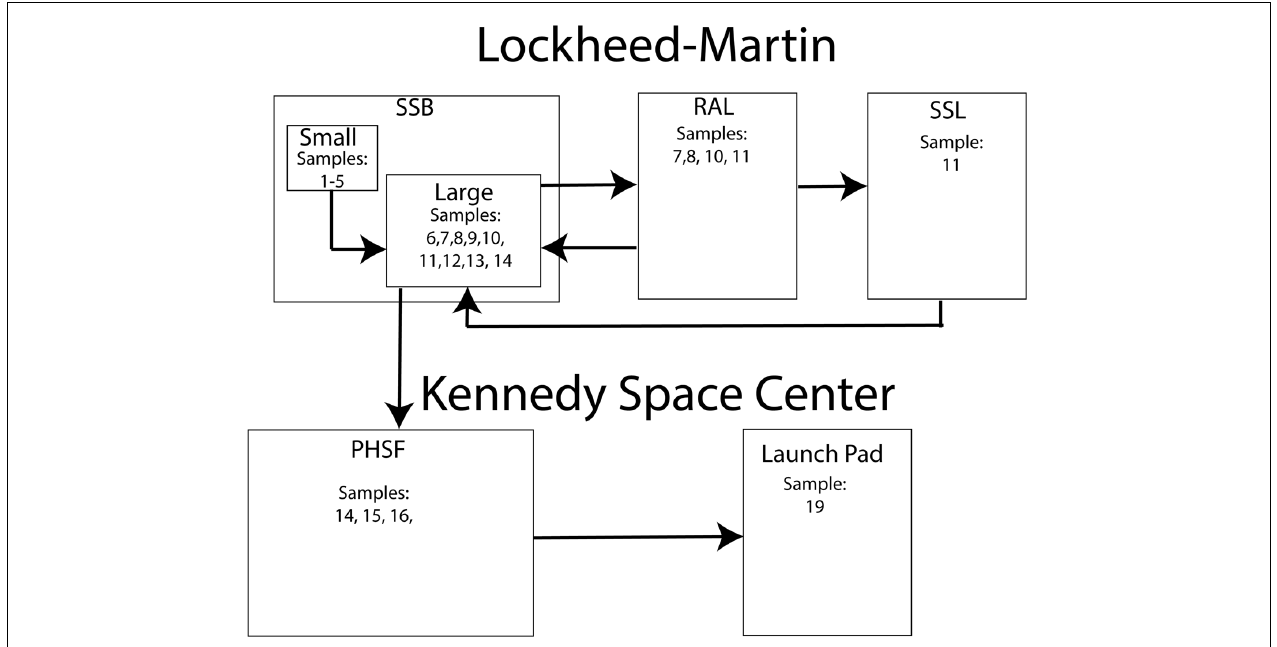
FIGURE 1 | A diagram describing the ATLO locations monitored with witness